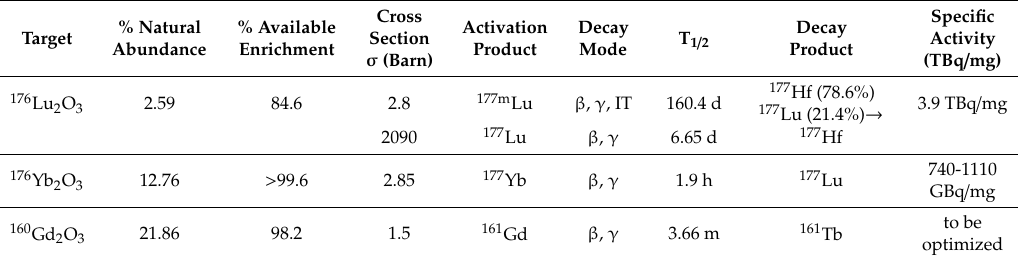
Table 7. Comparison of neutron activation products of 176 Lu, 176 Yb, and 160